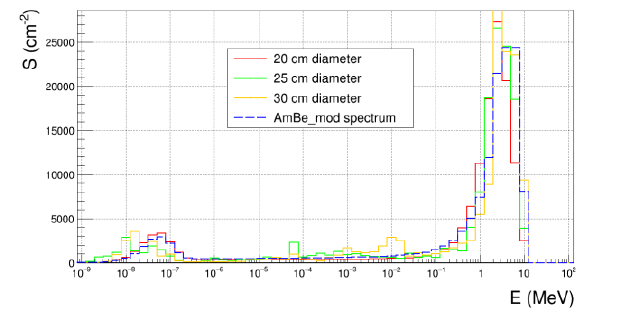
Fig. 3. Unfolding results (cm -2 ) as function of energy (MeV) obtained with G.R.A.V.E.L., for a moderated Am/Be source. The source spectrum is represented in blue dotted line. The unfolding results obtained with the 3 different Bonner sphere diameters, 20, 25 and 30 cm, are in red, green and yellow respectively. Surface fluence Φ = 1.41×10 5 cm -2 .